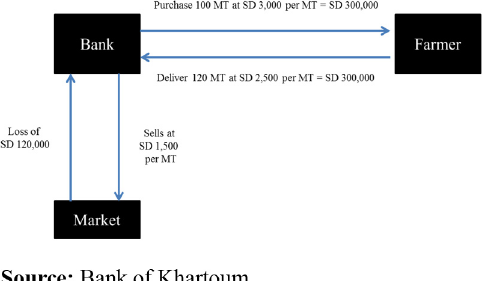
Figure 3. Case 2 – price